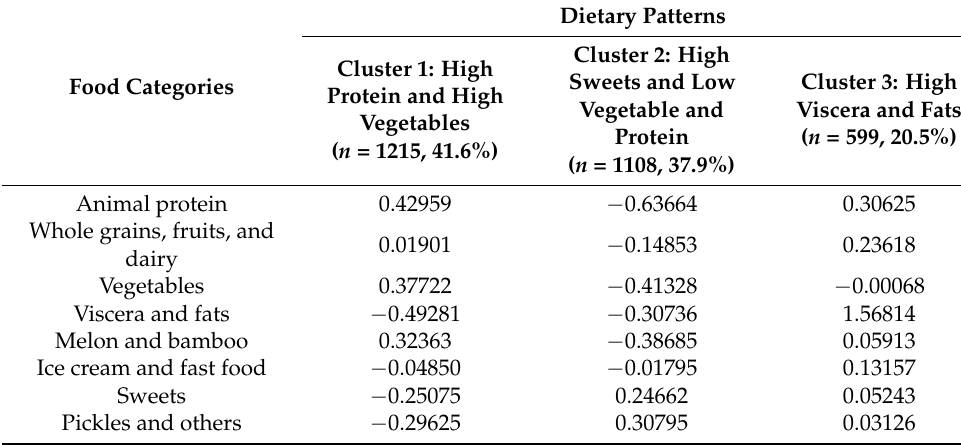
Table 2. Dietary patterns of older people identified by cluster